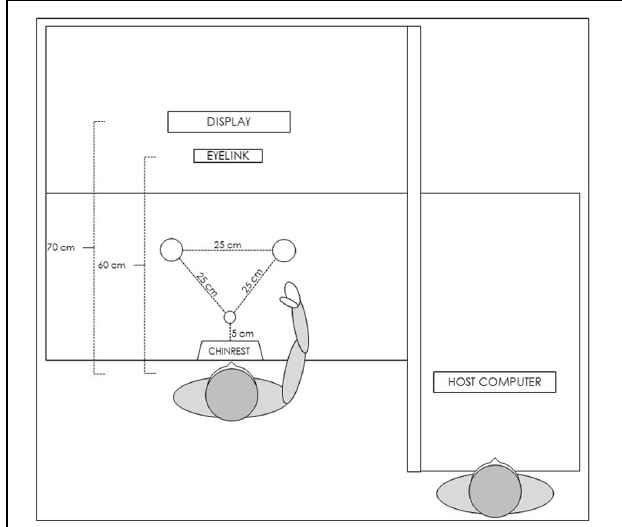
FIGURE 1 | Schematic representation of the experimental